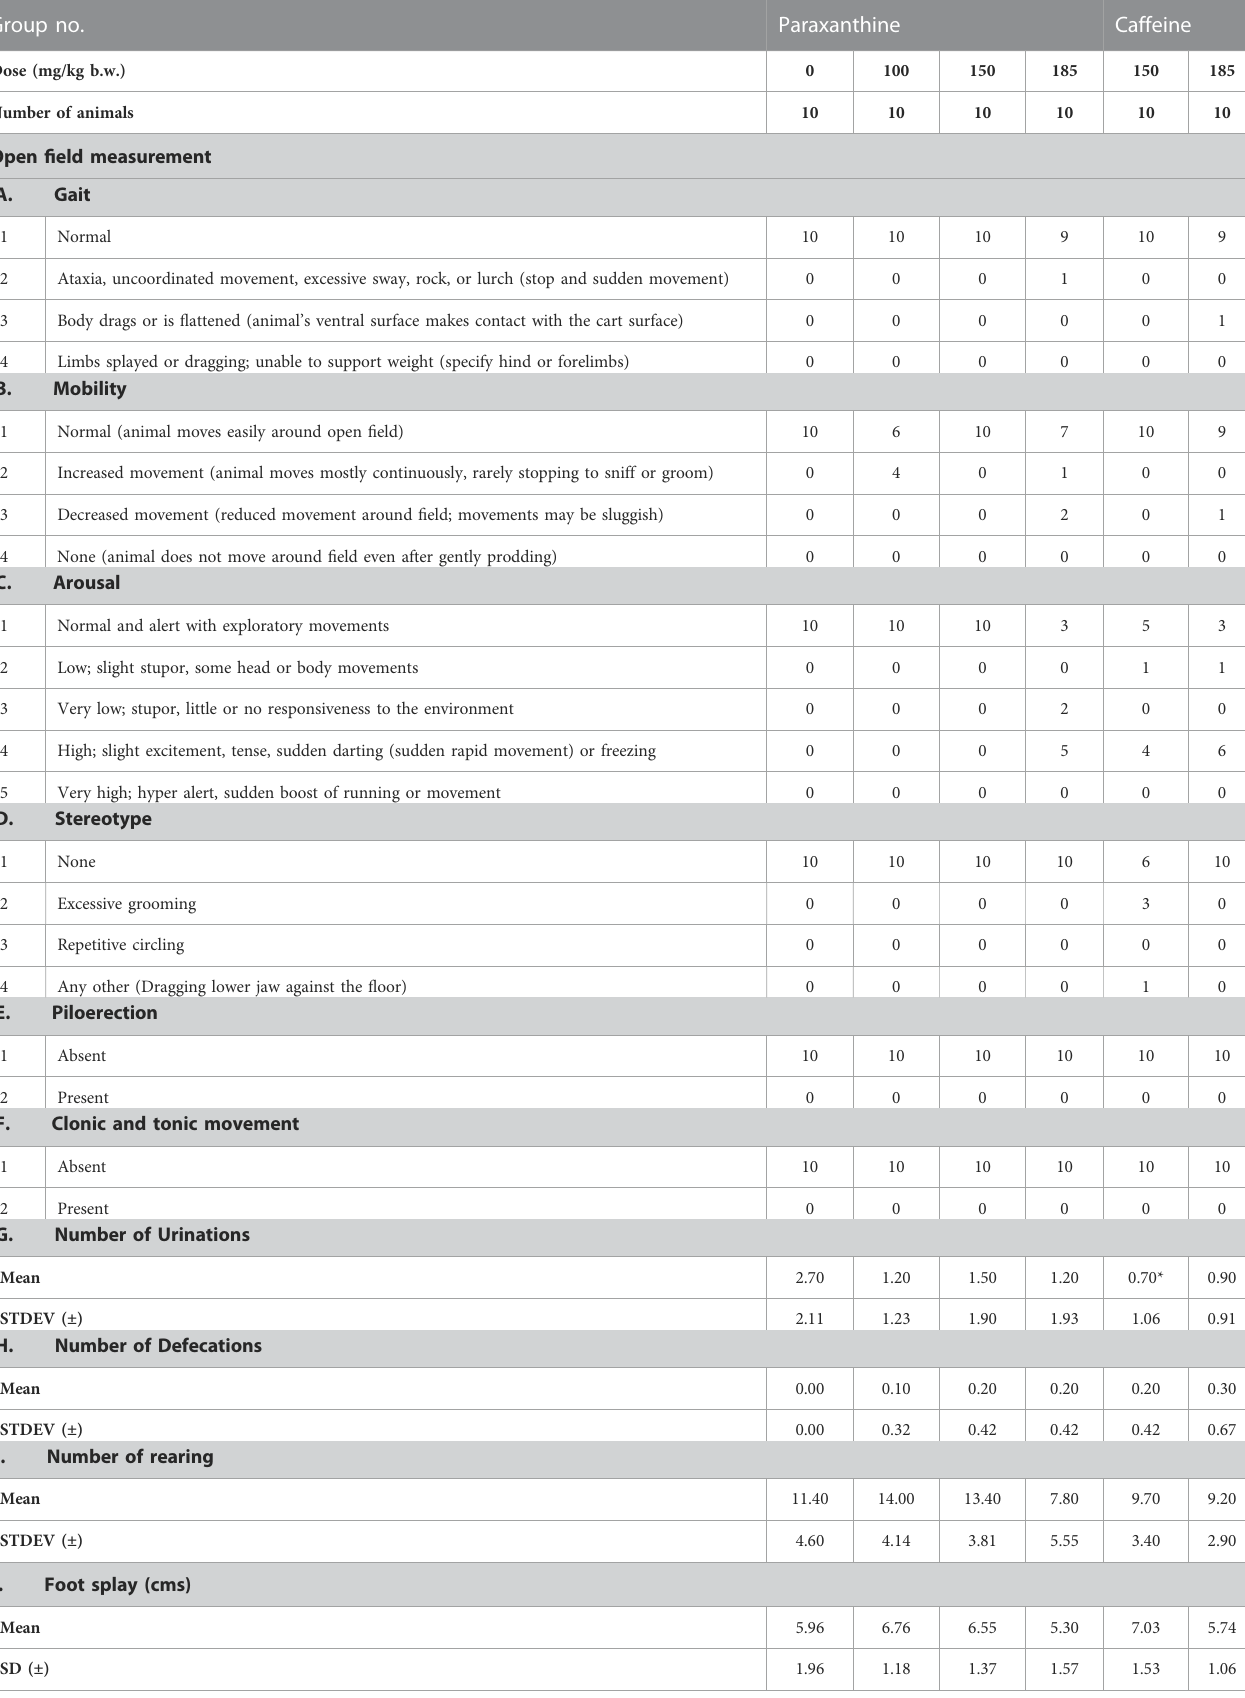
TABLE 3 Summary of functional observation battery test measurements in females in the repeat-dose 90-day toxicity study. The numbers represent the number of animals showing the respective observations. *Statistically signi fi cant ( p < 0.05) with respect to the control group (vehicle). Group no. Dose (mg/kg